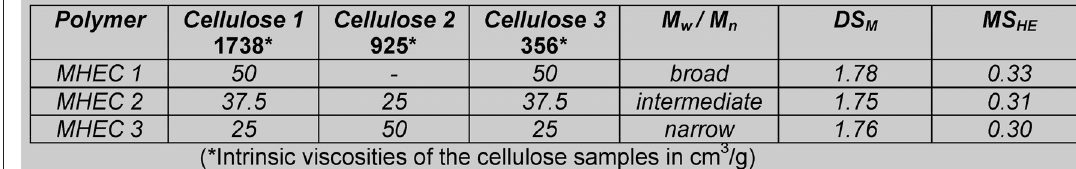
Table 1 (above): Blending composition, DS (degree of substitution for the methyl-group) and MS (molar degree of substitution for the hydroxyethyl-group) of the investigated MHECs 1-3. Figure 1 (below): Shear viscosity h versus shear rate g · for MHECs 1-3, 2 wt%, dissolved in aqueous NaOH (2 wt%) at